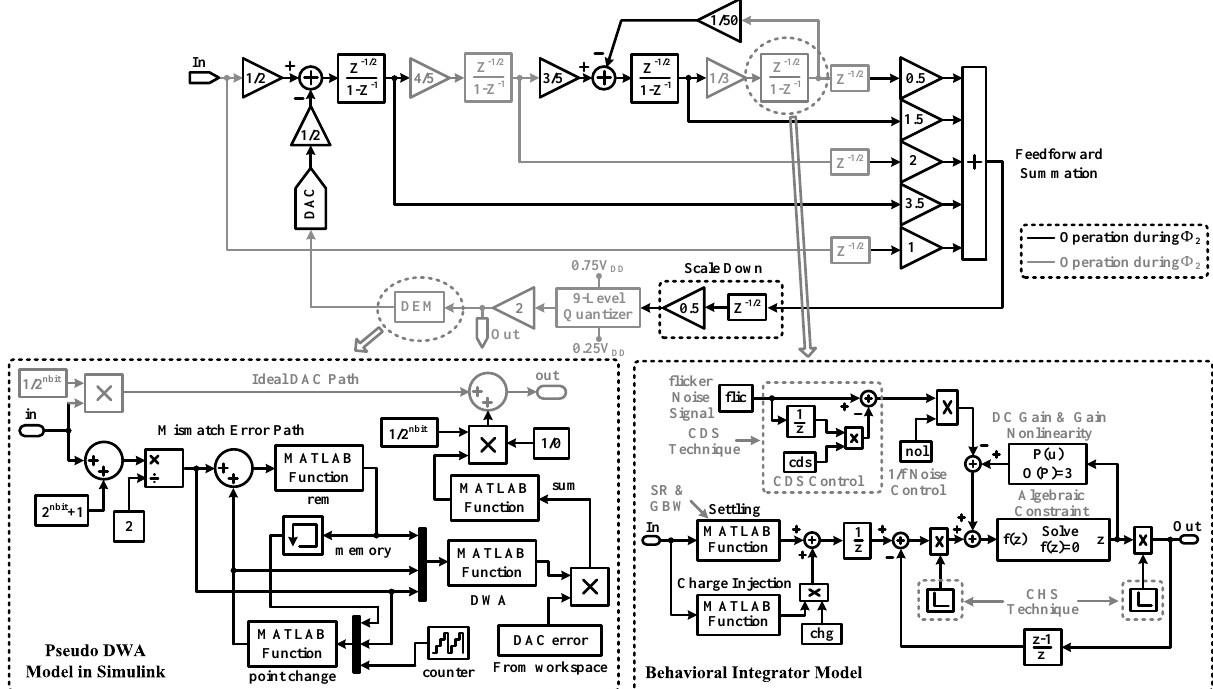
Figure 6. Block diagram of the proposed Delta-Sigma modulator with the behavioral integrator model [43,44] and the pseudo data weighted averaging (DWA)